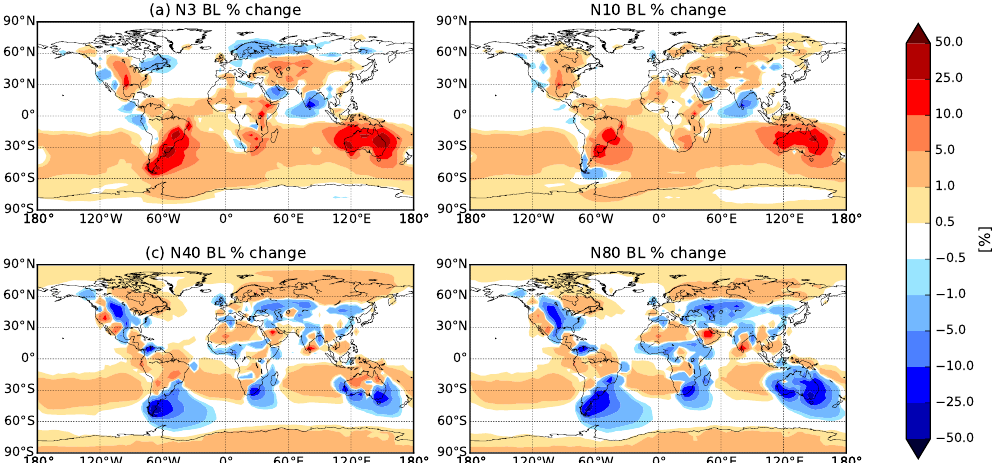
Figure 4. Percentage change in annually averaged boundary layer (a) N3, (b) N10, (c) N40, and (d) N80 (number of particles with diameter greater than 3, 10, 40, and 80nm, respectively) when changing MEGAN BVOC emissions from year 1000 to year 2000 with constant present-day anthropogenic emissions (2005) (BE2.AE2.meg–BE1.AE2.meg). Globally averaged, N3 and N10 increased by 2.3 and 1.5%, respectively, whereas N40 and N80 decreased by 0.6 and 1.3%, respectively (see Table 2). An increase in particle number concentration is represented in red, and a decrease in